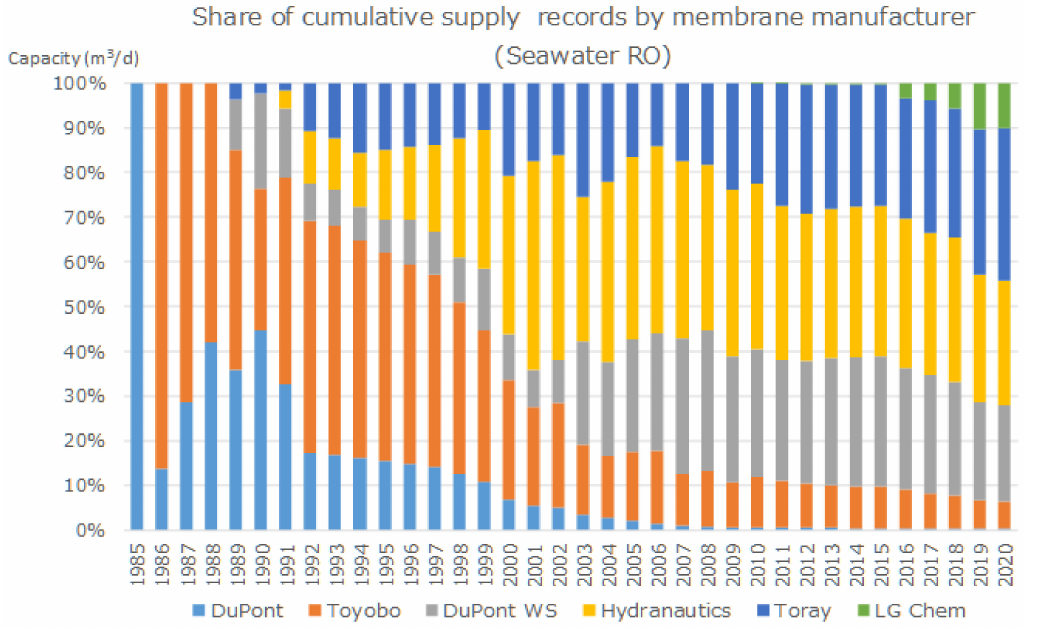
Figure 6. Share of cumulative supply records by membrane manufacturer